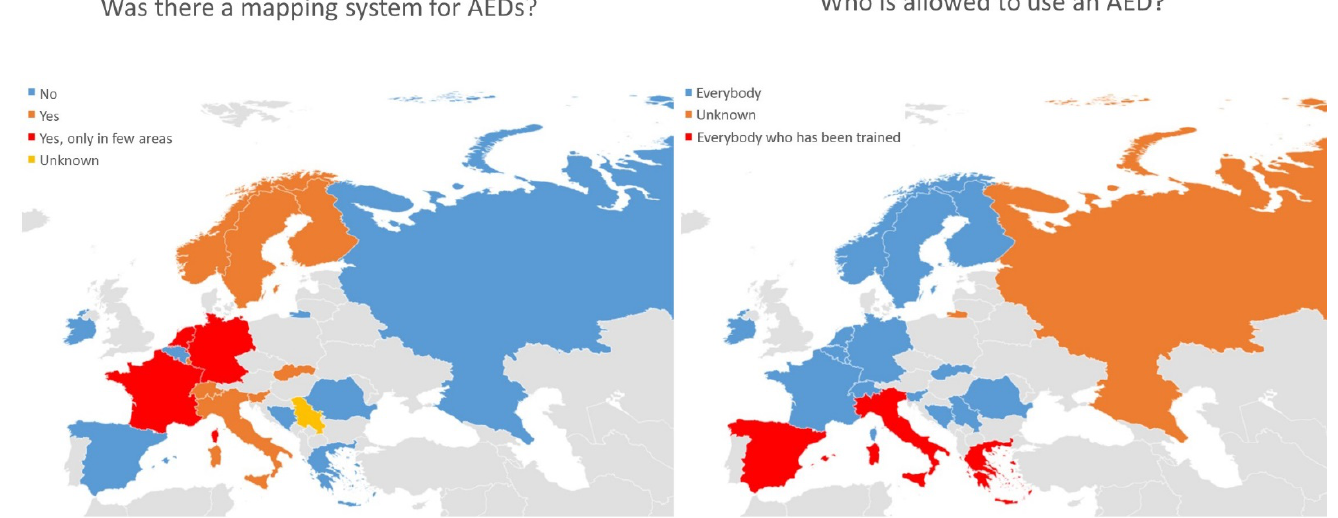
Figure 1. Graphical representation across the different European countries regarding who is, equipped with an AED, activated by the EMS, if there was an AED mapping system and who is allowed to use an AED. The data regarding the number of OHCA occurred, the use of an AED before EMS arrival, the ROSC and survival across the different european countries during the EuReCa TWO period (October 2017–December 2017) are presented in Table